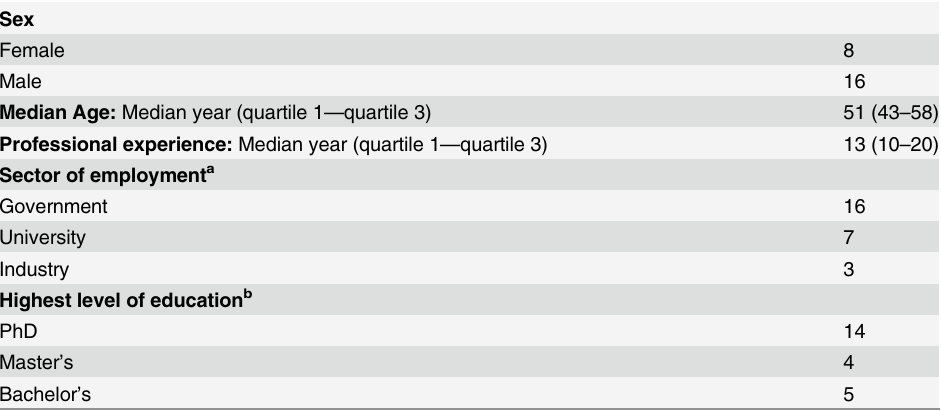
Table 2. Description of the Respondents who Completed the Delphi Survey (N = 24).